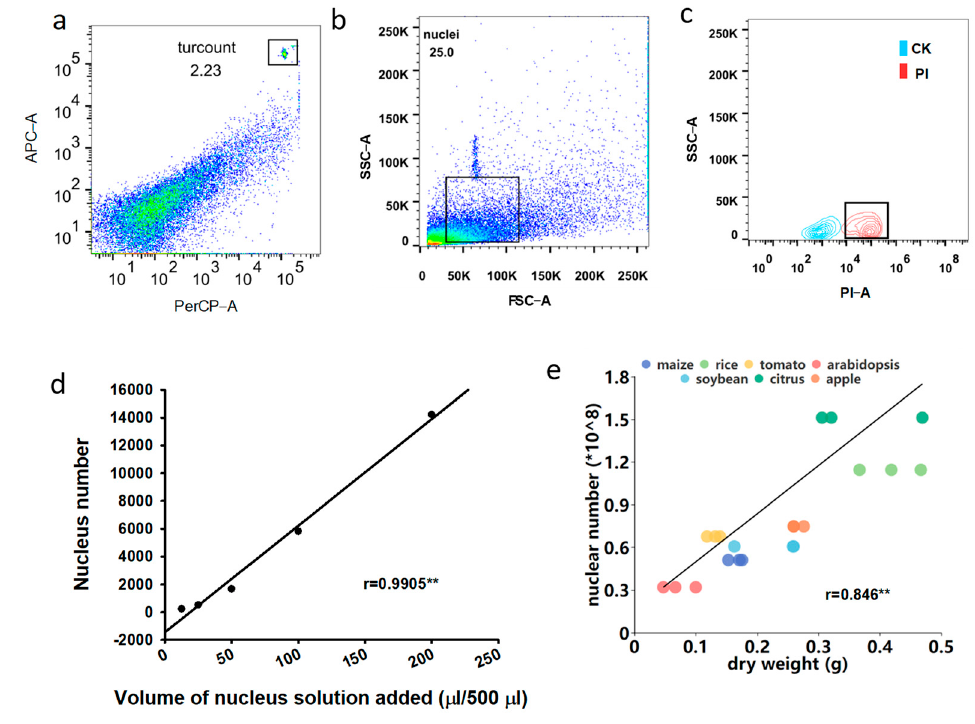
Figure 4. Nuclei absolute quantitative logic using flow cytometry. ( a ) Dot plot of trucount beads selected by PerCP-area versus APC-area. ( b ) Dot plot of nuclear position selected by FSC versus SSC. ( c ) Contour plot of PI positive nuclei (red) and control nuclei (blue). Plot c produce based on the rectangular part of plot b. ( d ) Linear regression curve of nuclei solutions. ** indicate significant correlation at p < 0.01. ( e ) The absolute counts of nuclei from leaf sample of maize, rice, soybean, arabidopsis, tomato, citrus and apple were positively correlated with the dry weight.